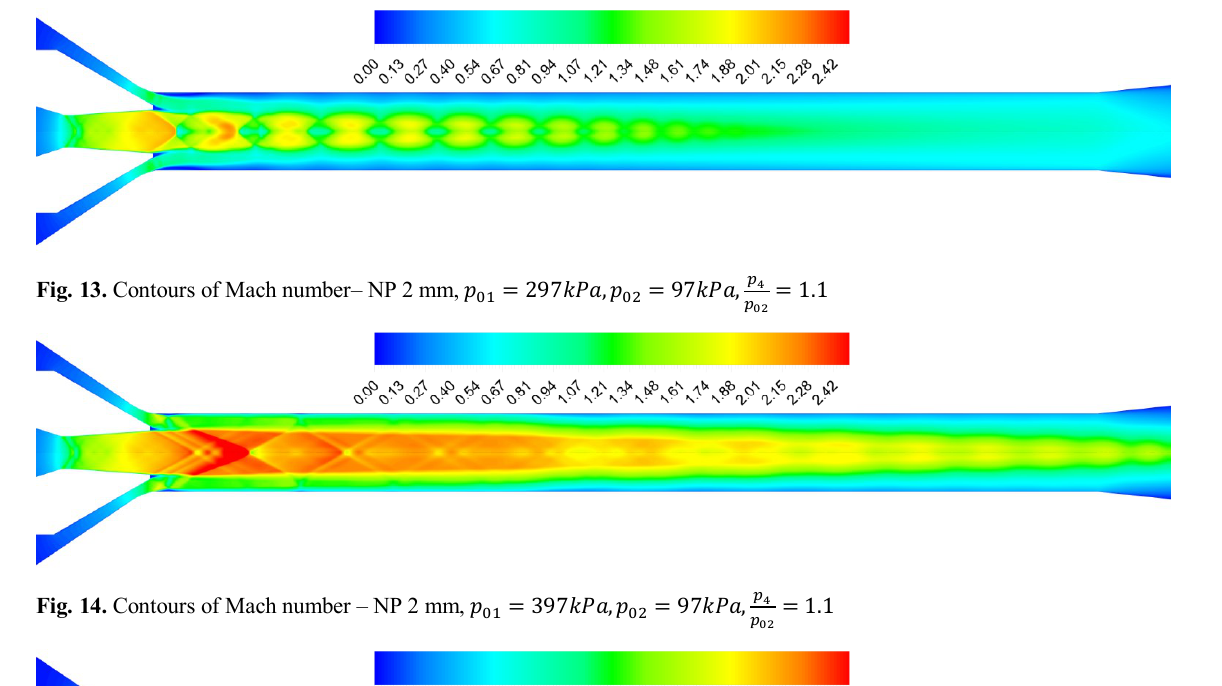
01 = 397𝑘𝑃𝑎,𝑝 02 = 97𝑘𝑃𝑎,